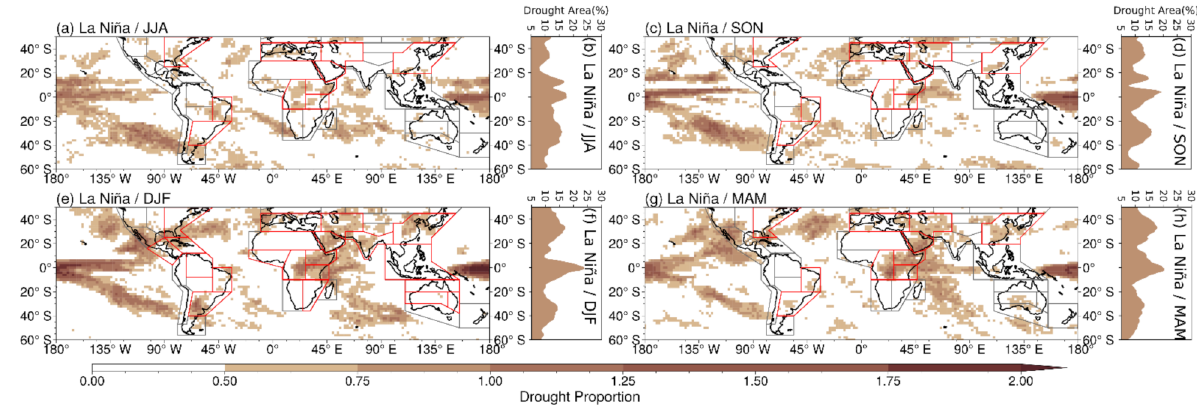
Figure 5. The same as Figure 4, but for La Niña.